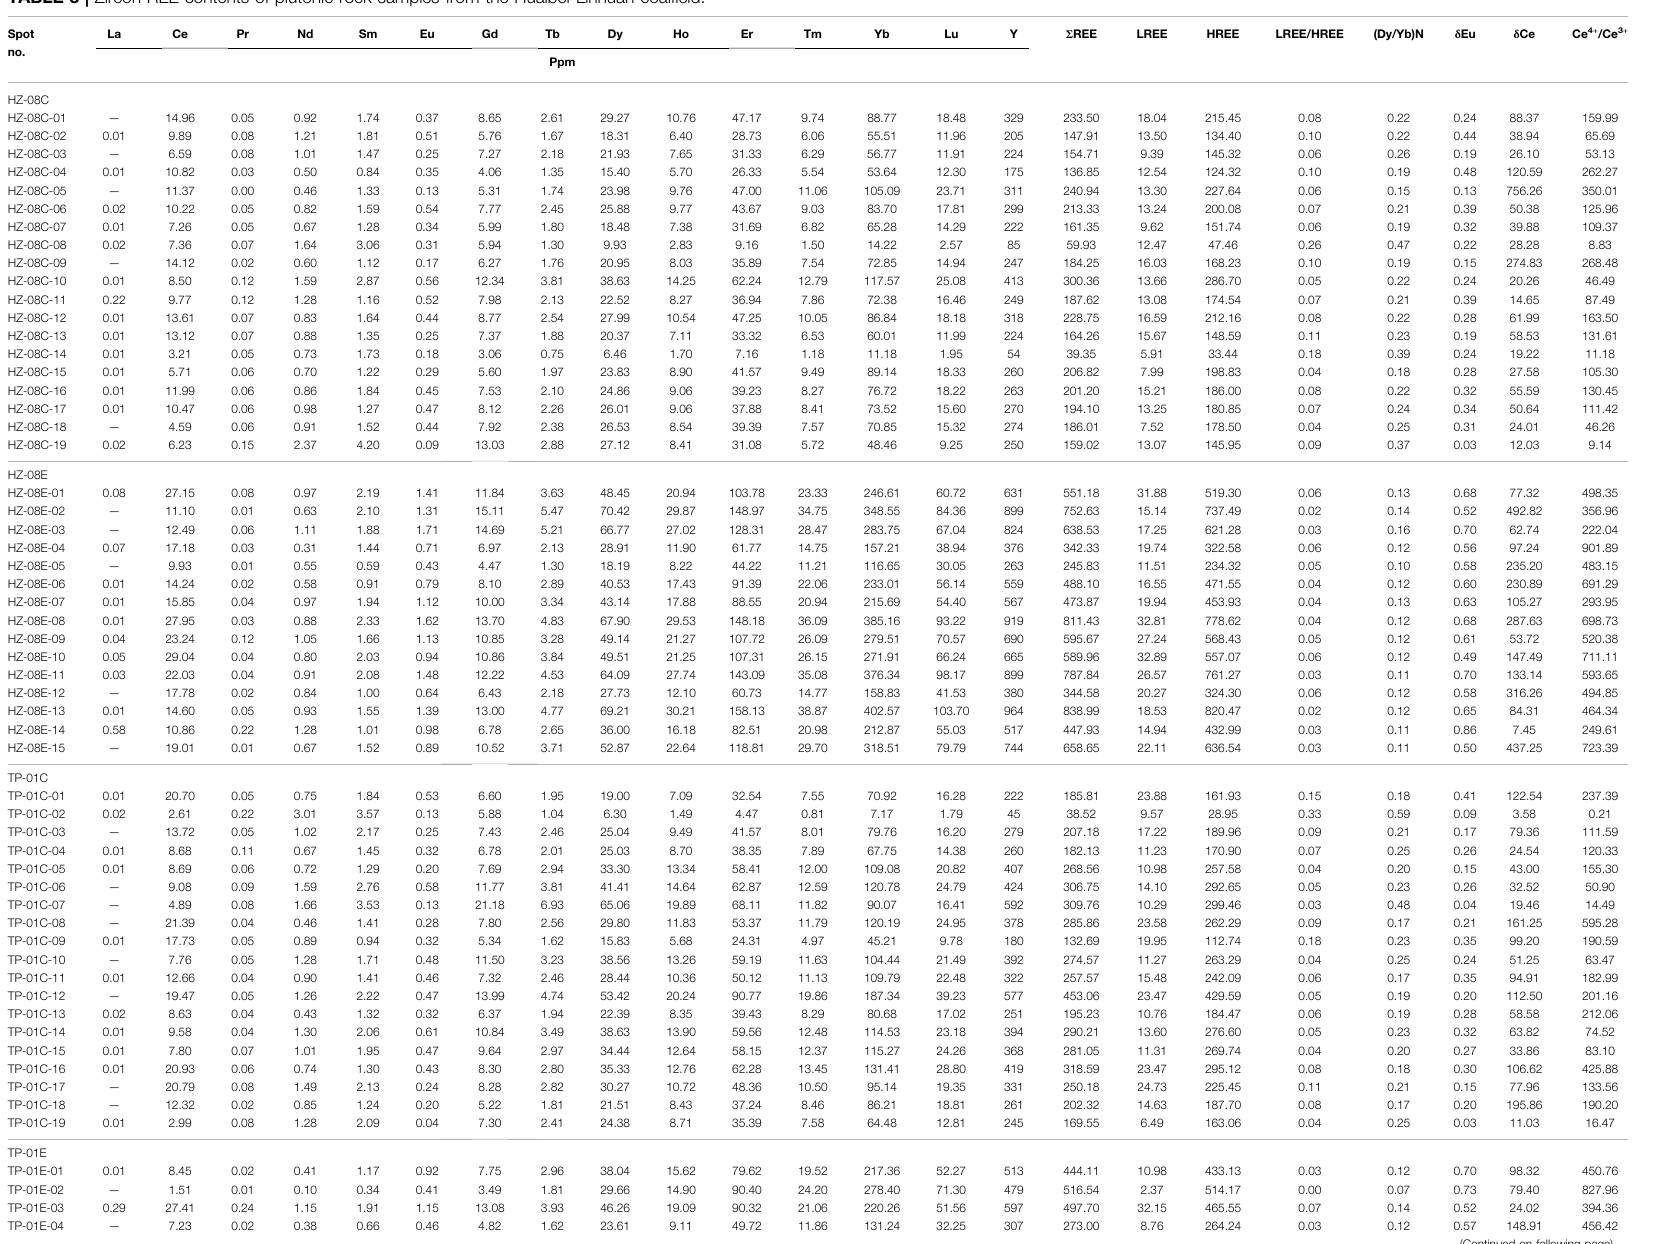
TABLE 3 | Zircon REE contents of plutonic rock samples from the Huaibei-Linhuan coal fi eld. Spot